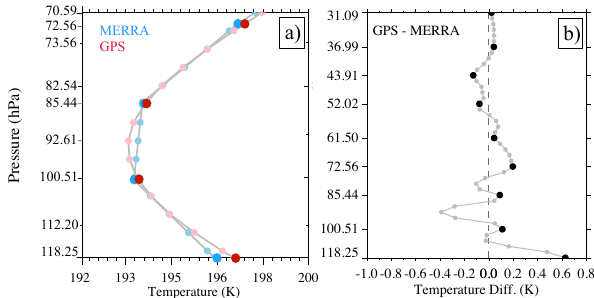
Figure 3. Cold-point temperature differences between MERRA ad- justed by waves and MERRA (MER-Twave–MER-T) during 2007– 2013. The probability density function in black is plotted on the left y axis and cumulative distribution function in blue on the right y